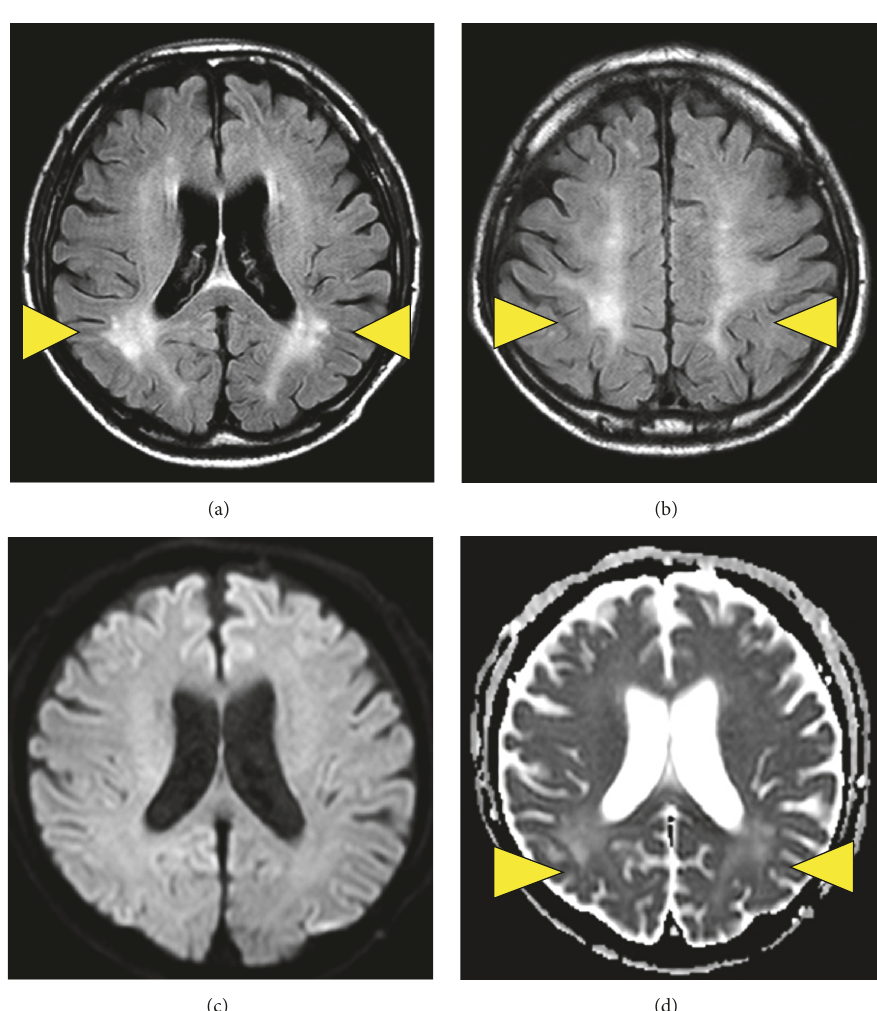
Figure 4: Cranial MRI taken on day 15, showing brain edema. ((a), (b)) T2-weighted FLAIR MRI showing increased signal intensities bilaterally in the cortical and subcortical areas of the occipital lobe (arrowhead). (c) DWI demonstrates no hyperintense signal alterations in these regions. (d) ADC is elevated in bilateral occipital lesions